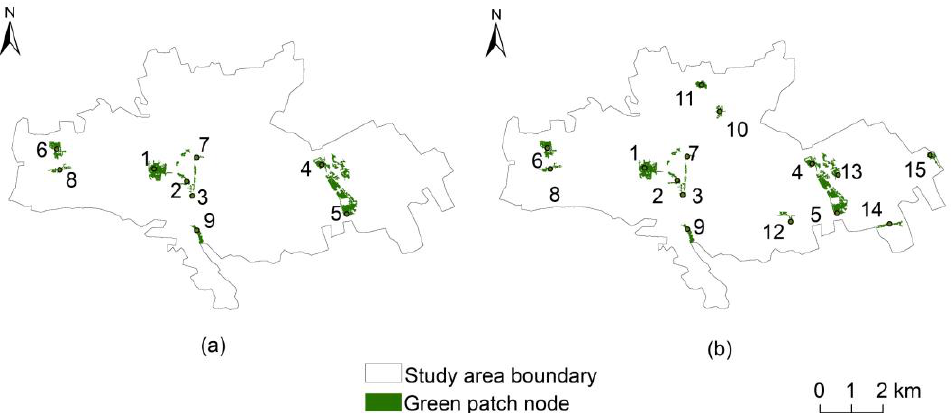
Figure 6. Spatial distribution of the selected green patch nodes: ( a ) recreational green space nodes; ( b ) ecological green space patch nodes. Note: (1) People’s Park; (2) East Lake Park; (3) South Lake Park; (4) Xiao Yalang Wetland Park; (5) Dongcheng Park; (6) West Park; (7) Times Squar; (8) Chalbagh Style Park; (9) Kashgar River; (10) Woodland; (11) Xiangfei Garden; (12) Shade belt; (13) Woodland; (14) Kashgar University; (15) Shang Yalang Reservoir.